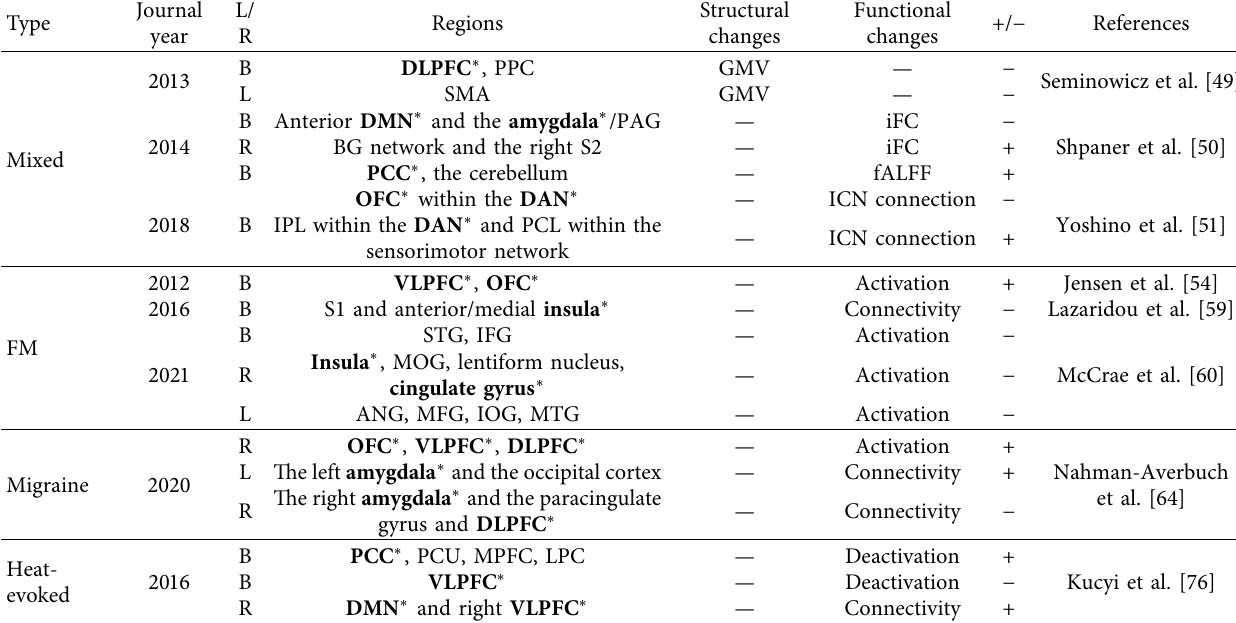
Table 1: Comparison of findings on neuroimaging changes in CBT for pain-related